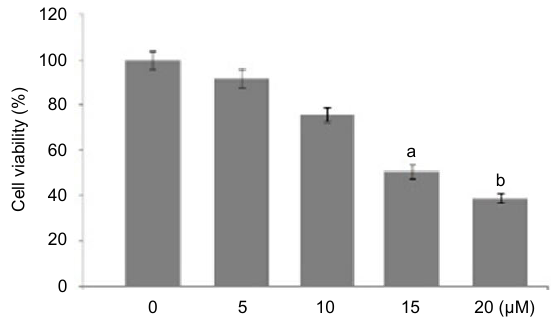
Figure 1: Zerumbone treatment caused proliferation inhibition in DU-145 carcinoma cells. The cells were incubated in presence of 5, 10, 15 and 20 µM zerumbone for 48 hours or left untreated as control and then analyzed by MTT assay. The values ex- pressed are the mean ± SEM in relation to DMSO treated cells.